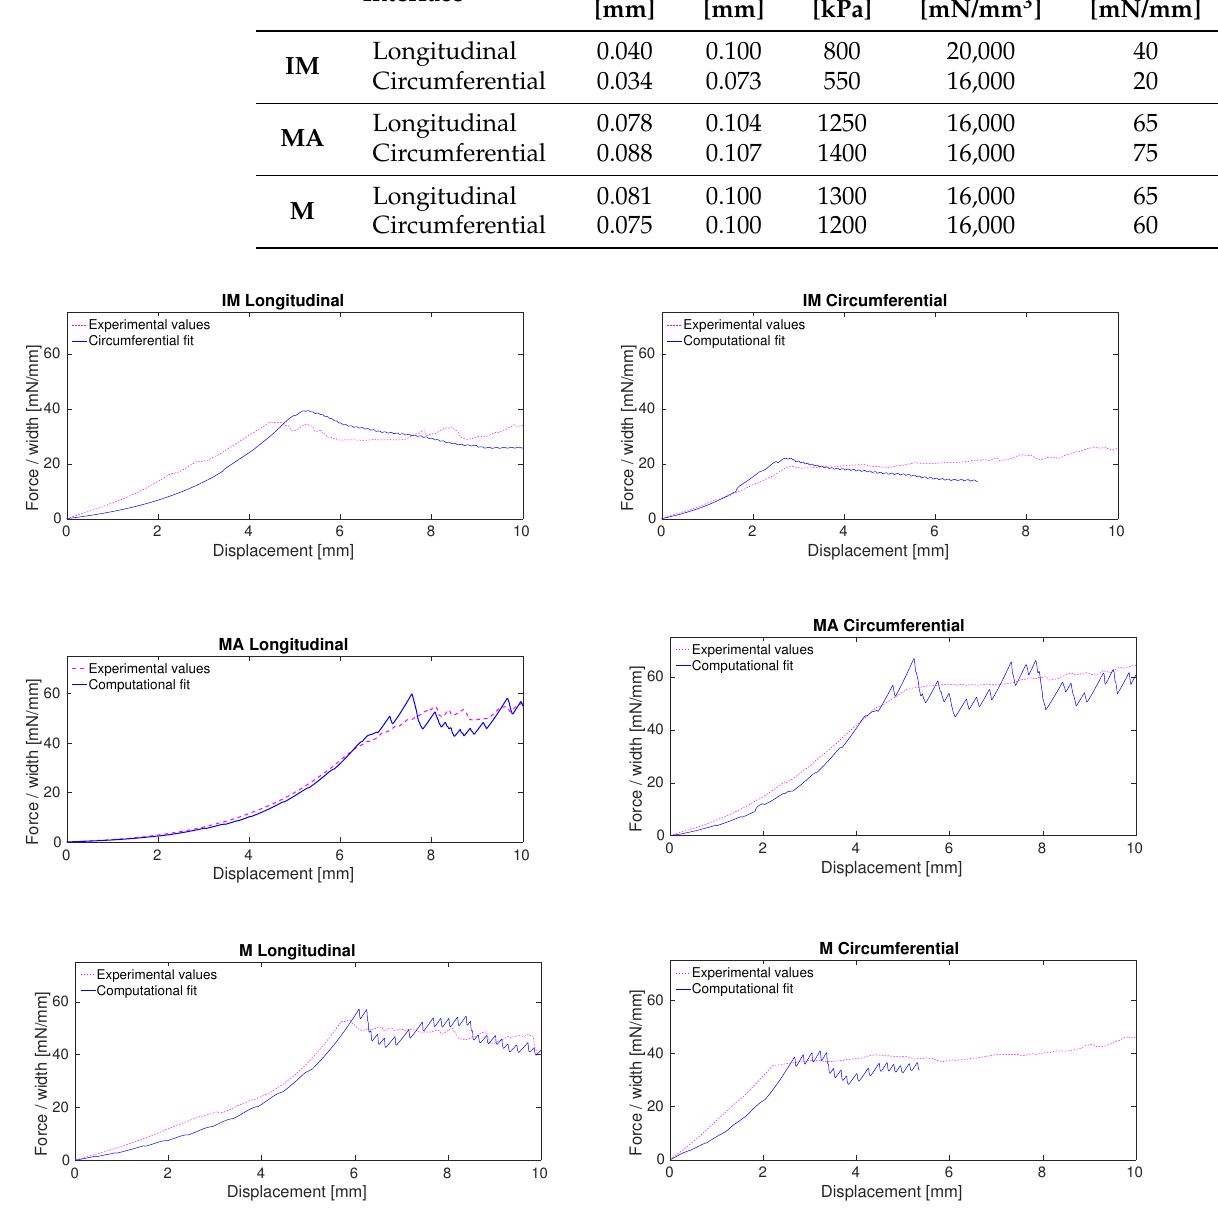
Figure 5. Correlation between force/width vs. displacement curves and computation of the mixed test of the interfaces intima-media, media-adventitia and media for longitudinal and circumferential